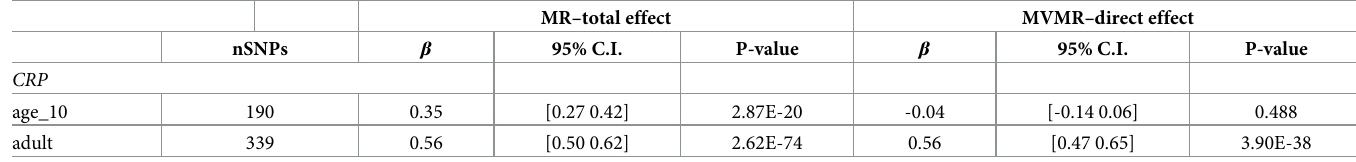
Table 4. Univariable and multivariable estimates for effect of child and adulthood BMI liability on circulating CRP.